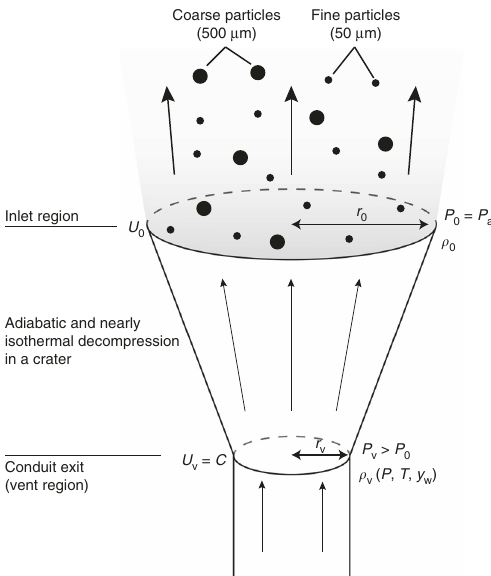
Fig. 5 Numerical model setup. Schematic drawing of a volcanic jet, illustrating the de fi nitions of the parameters before (vent region) and after decompression (inlet region) of the mixture, where U 0 , ρ 0 , and r 0 are the dependent source conditions of the numerical domain. The adiabatic decompression (from P v > P 0 ) of the mixture is computed analytically assuming a correct expansion 13 , in which all quantities are uniform (i.e.,